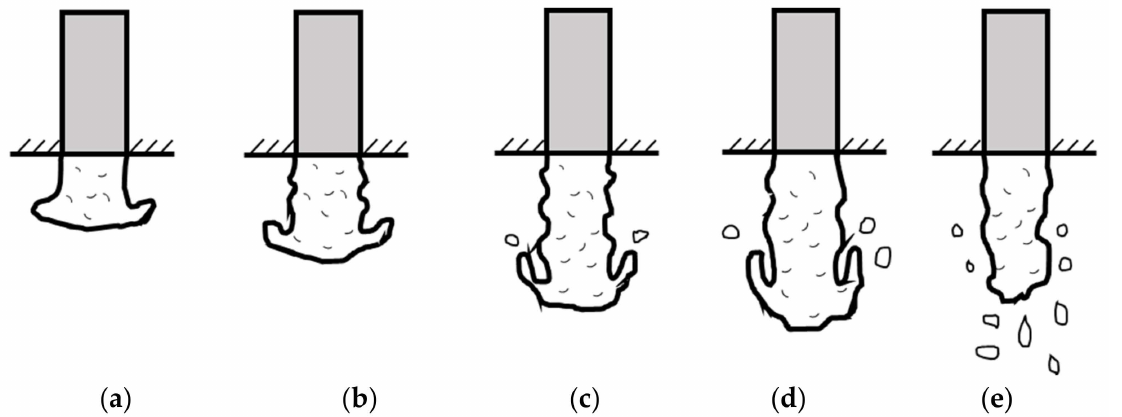
Figure 1. Liquid fuel spray breakup. ( a ) liquid column; ( b ) mushroom head occurs; ( c ) liquid film broken up; ( d ) large droplets occur; ( e ) small